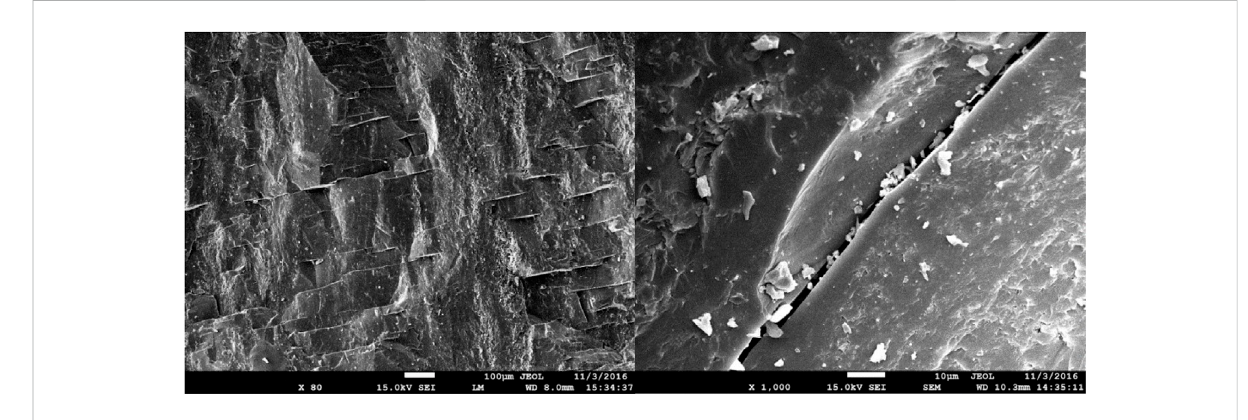
FIGURE 5 Microfractures in the Hongshandian mining area.